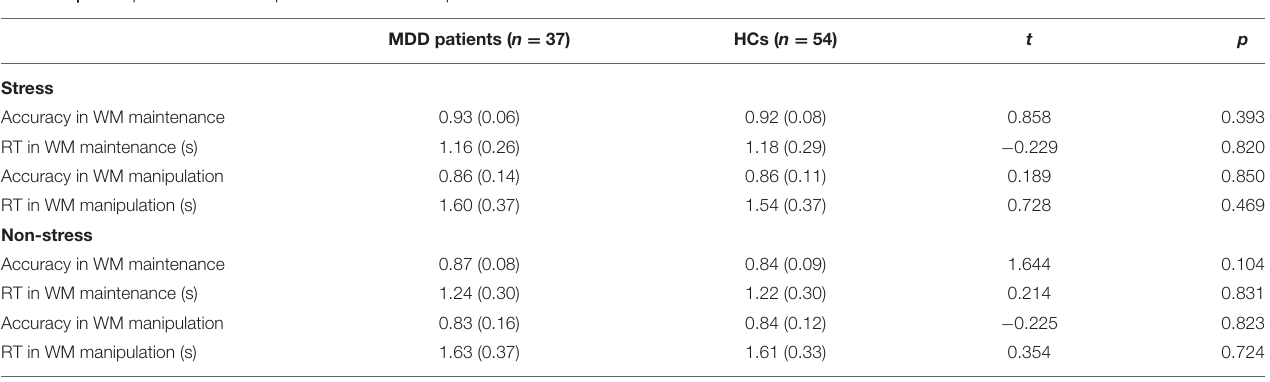
TABLE 2 | Description of behavioral performances of MDD patients and